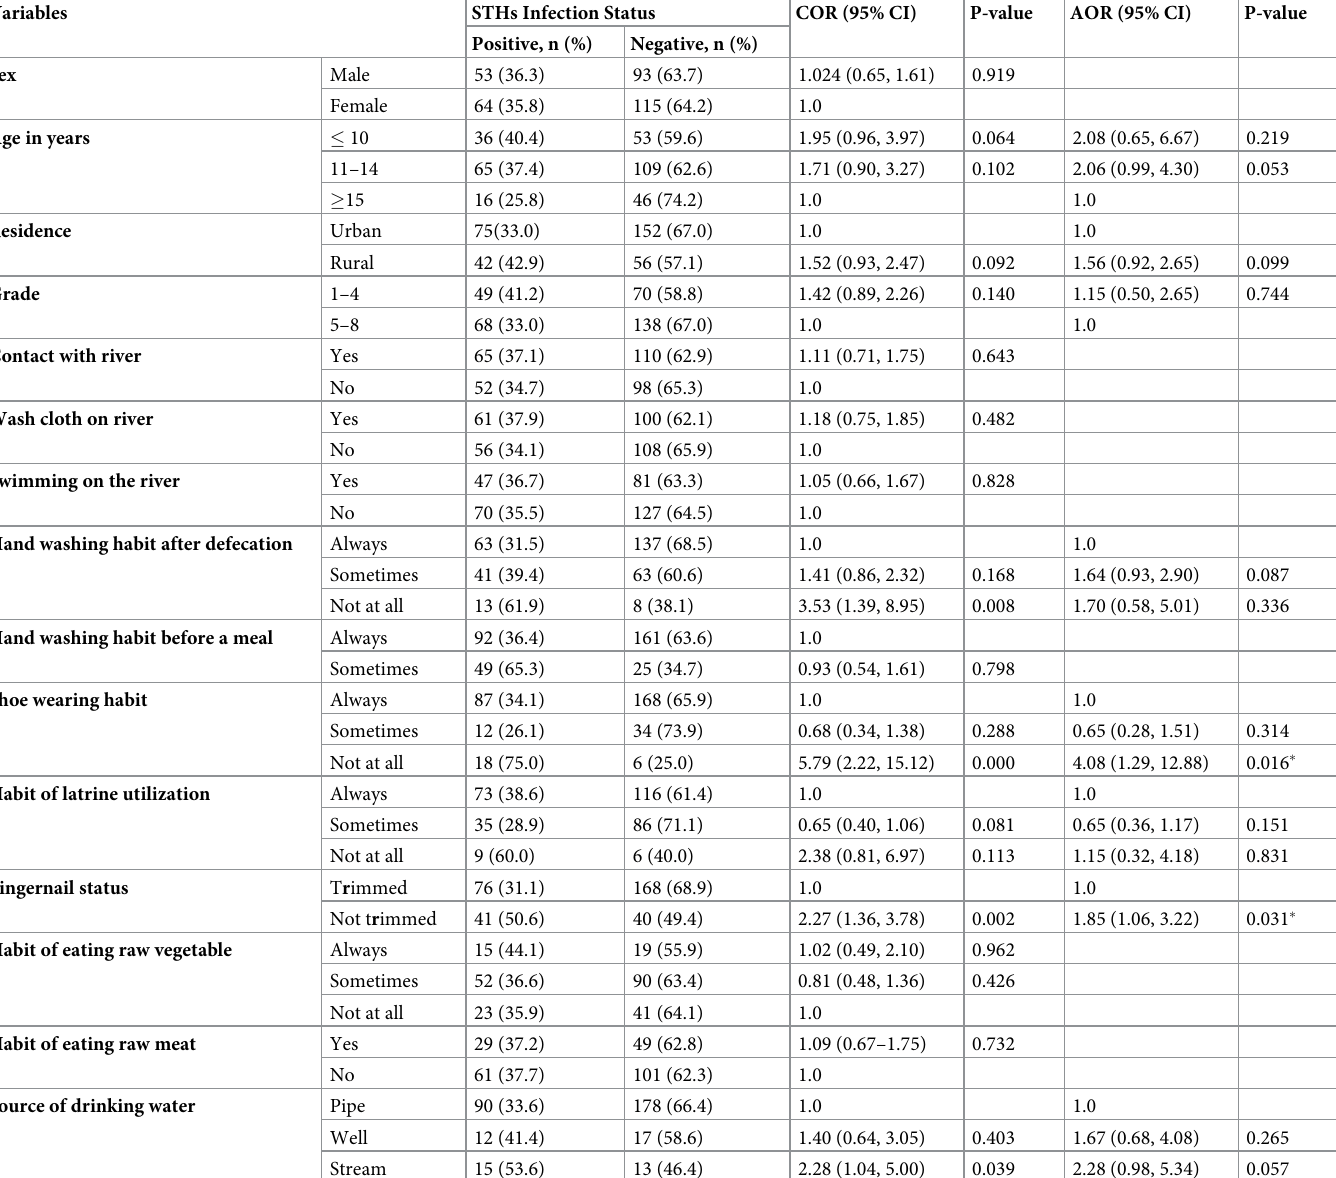
Table 4. Bivariable and multivariable logistic regression analysis of associated factors of STH infections among school children of Tachgayint woreda, Northcentral Ethiopia, 2021.